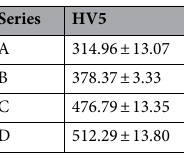
Table 2. Results of the hardness measurements via Vickers method. Series: A—0%, B—1%, C—5%, D—10%.